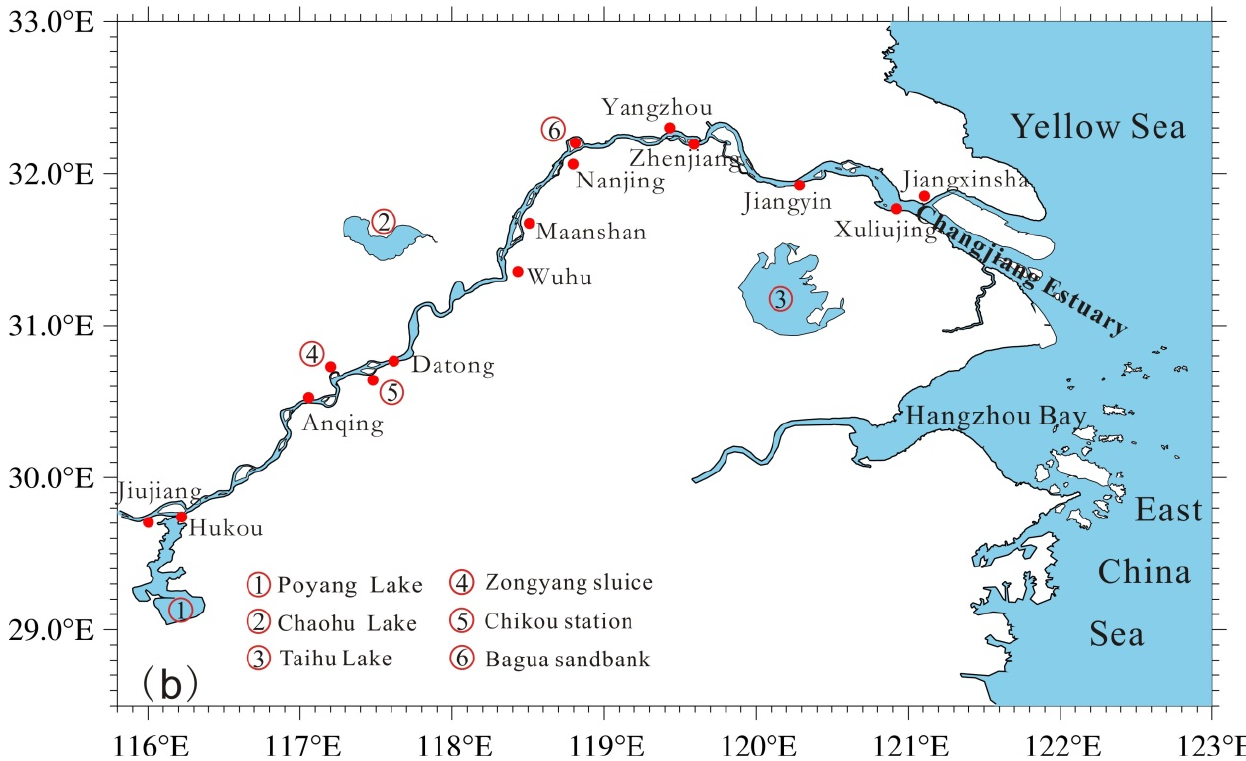
Figure 1. Map of the lower reaches of the Changjiang River from Jiujiang to the river mouth.